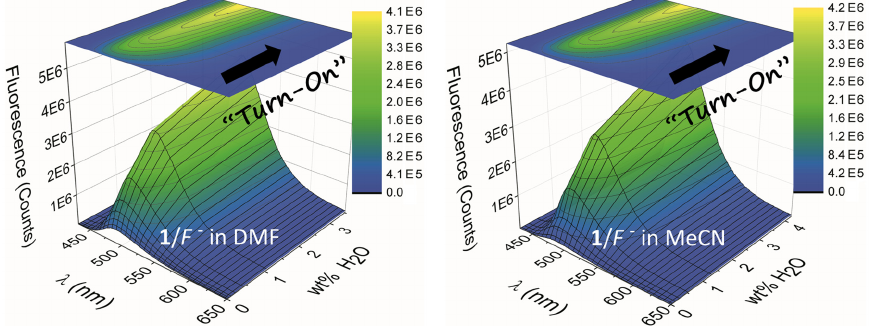
Figure 1. Evolution of the fluorescence spectrum of two-component coumarin oxime 1 /F − sensor in DMF and MeCN during its titration with water (DMF: 2 × 10 − 5 mol L − 1 1 + 1 × 10 − 2 mol L − 1 TBA + F − ; MeCN: 5 × 10 − 5 mol L − 1 1 + 1 × 10 − 2 mol L − 1 TBA + F − ; λ EX = λ A(oxime) ; T = 298.15